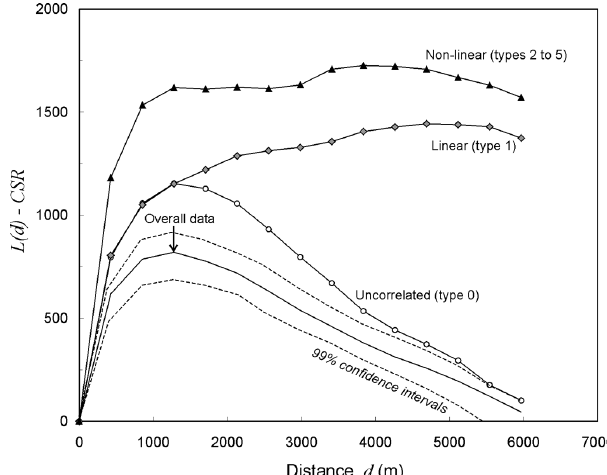
Fig. 8. (a) pie chart showing the relative frequency of the six target trends in the test dataset (type 4 and 5 are not distinguished because of the low percentage); (b) frequency distributions of the mean ve- locity for the different target trends (“non-linear” trends includes types 2 to 5).